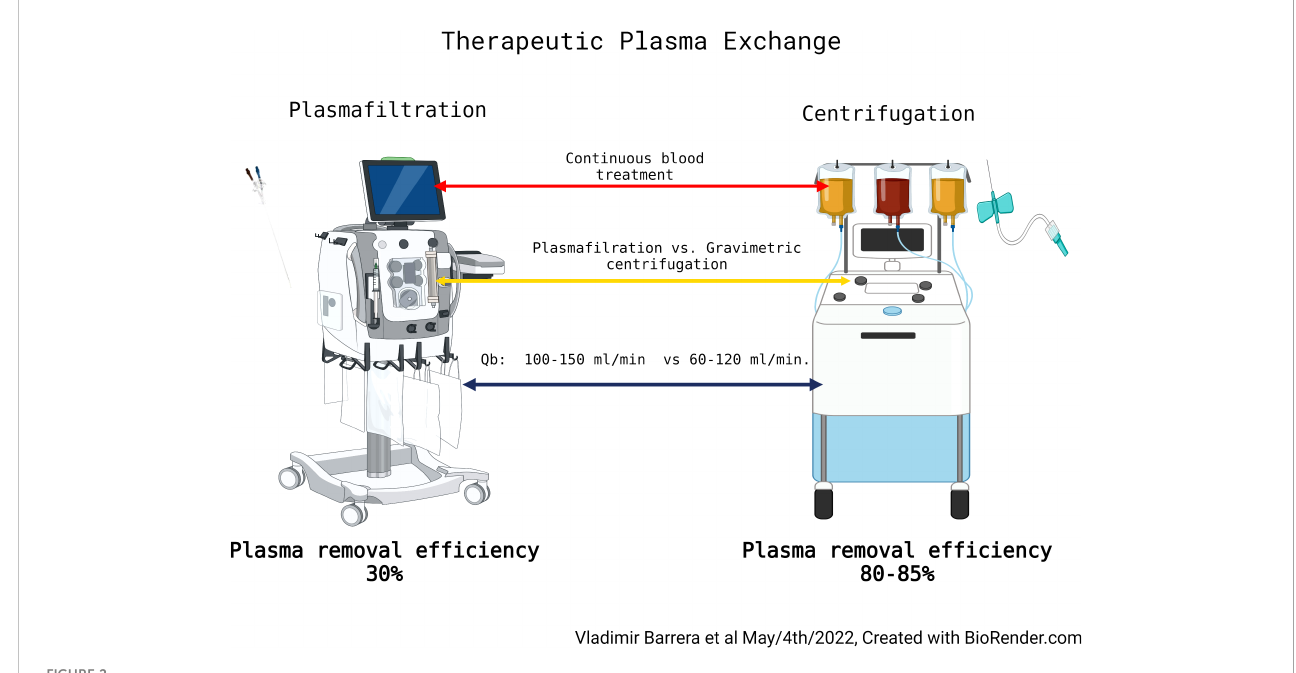
FIGURE 2 Therapeutic plasma